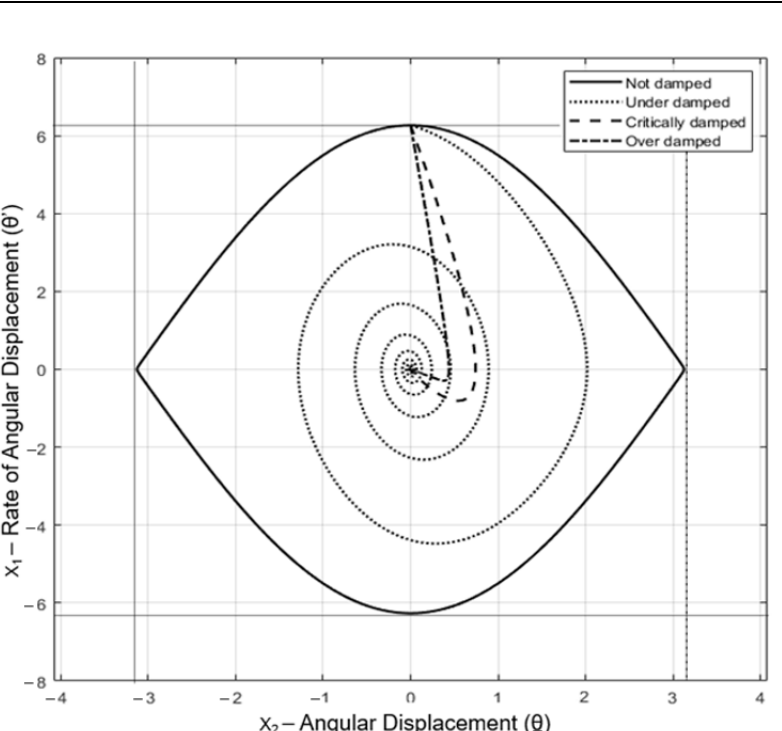
Figure 16. Phase portrait indicative of the system’s soft thresholds disturbed by initial conditions (Case example 2).